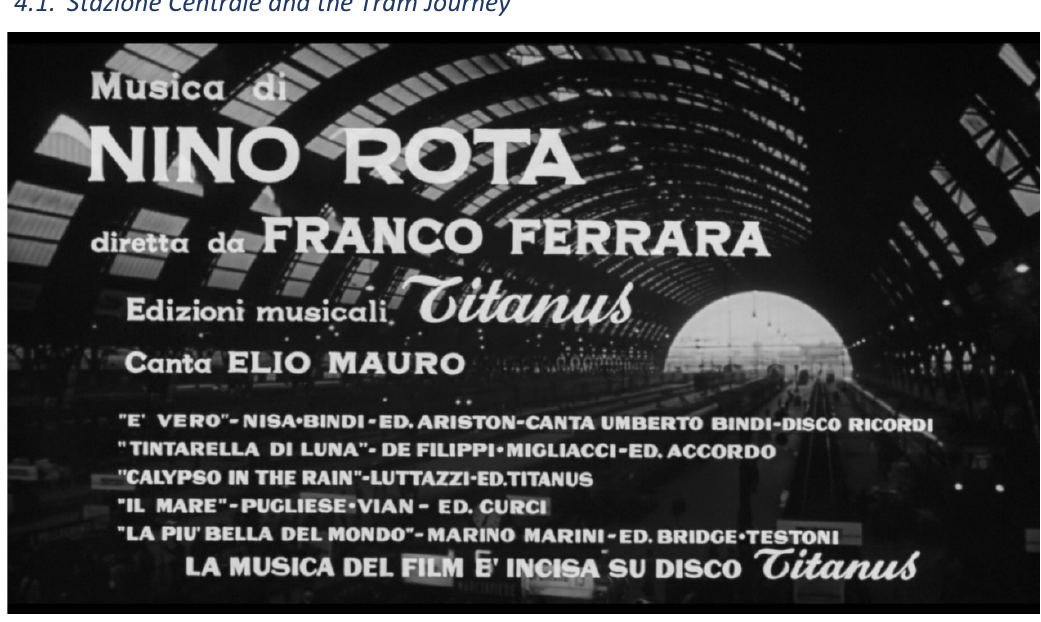
Figure 5 Opening Title. Screenshot from Rocco and His Brothers. (Goffredo